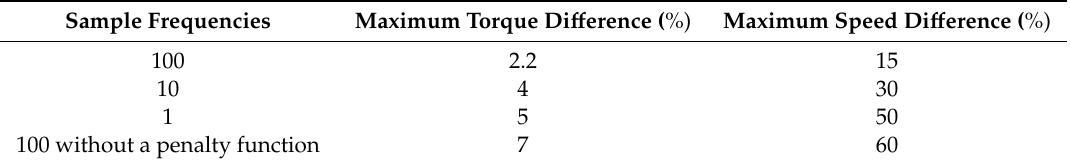
Table 3. The influence of T p on RLS with di ff erent sampling frequencies. Sample